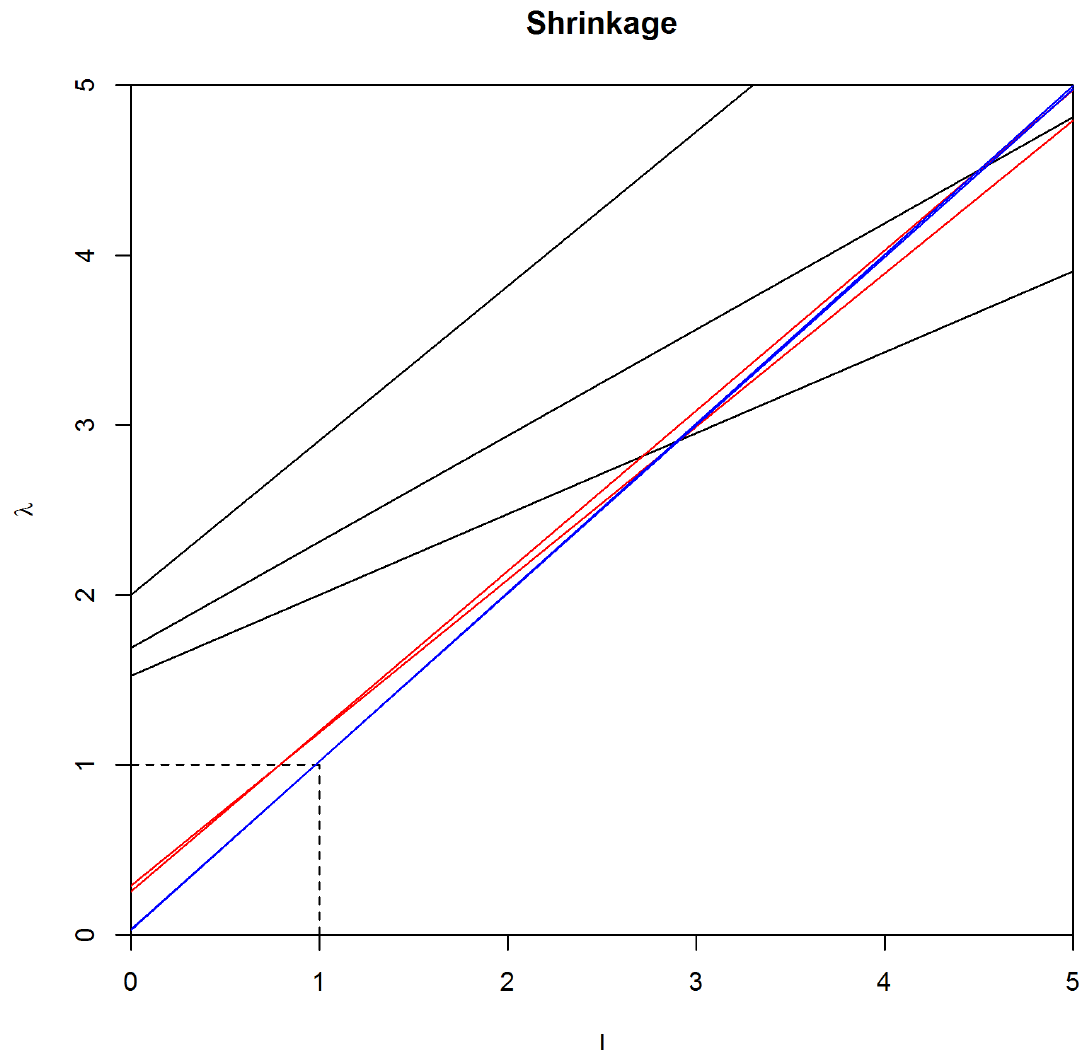
Fig 4. Linear shrinkage of the eigenvalues. Shrinkage of the eigenvalues of the MAP of the covariance matrix as r = α . When n < p , all eigenvalues increase when r is small but when r increases, the increment gets more moderate (black lines). When n increases, shrunken eigenvalues get closer to the sample eigenvalues and the growth of r does not significantly affect the estimated eigenvalues (red lines). When n (cid:6) p , estimated eigenvalues start to coincide to the sample eigenvalues (blue lines).